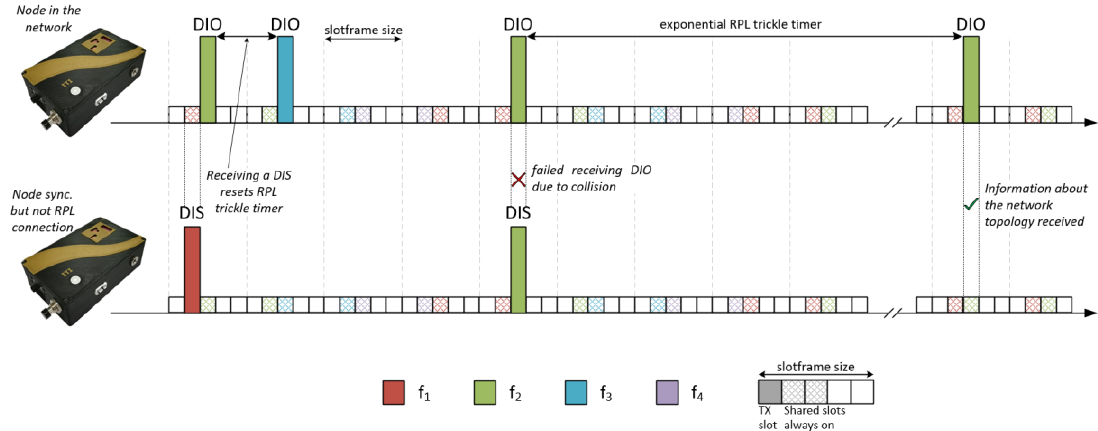
Figure 4. Exchange of RPL control messages. DIS, DODAG Information Solicitation.